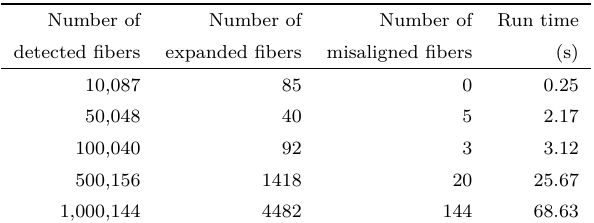
Table 1 Run time (excluding circle/ellipse detection) for real-world inputs with different numbers of detected fibers Number of